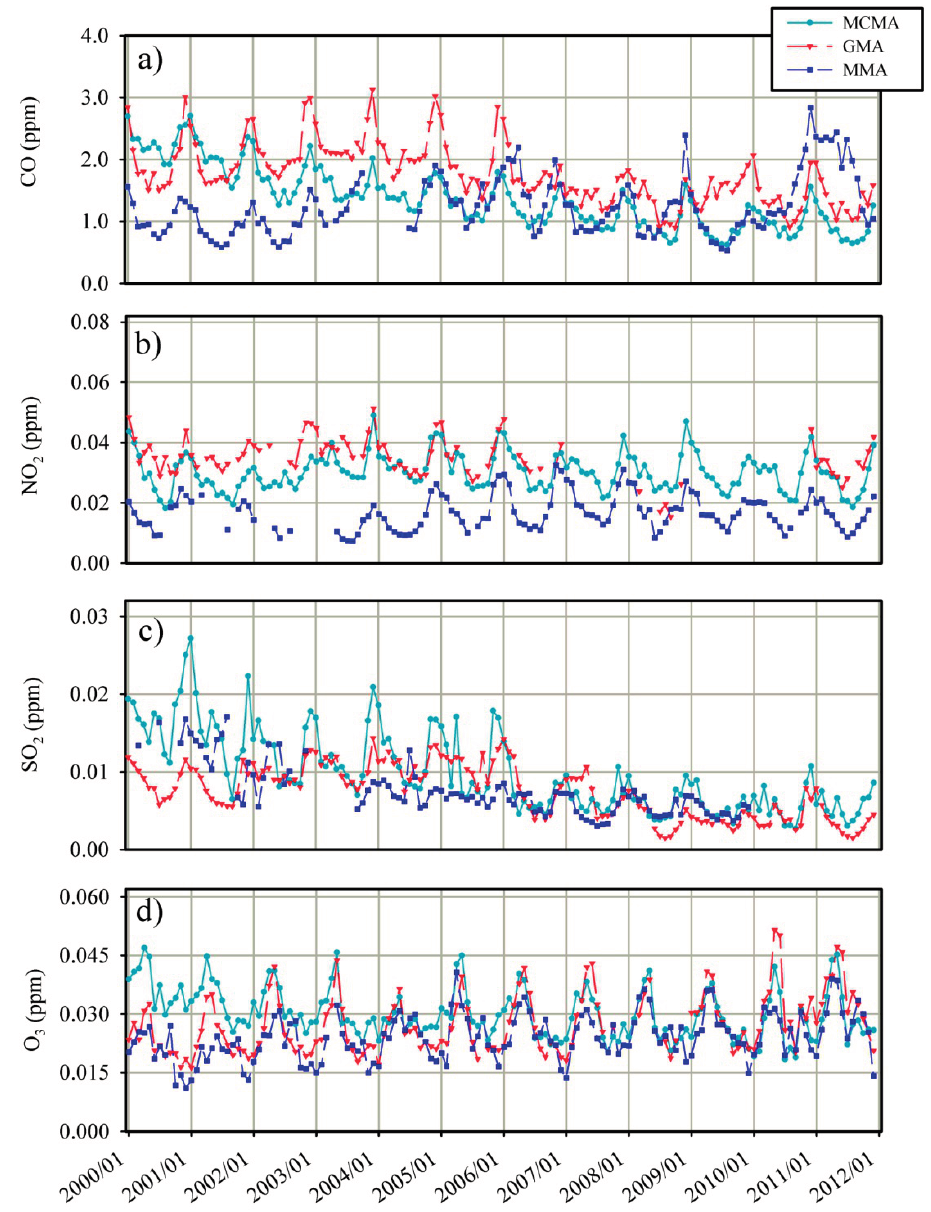
Figure 2. Variation of the monthly average concentrations of ( a ) CO, ( b ) NO and ( d ) O in the three Mexican metropolitan areas from 2000 to 3